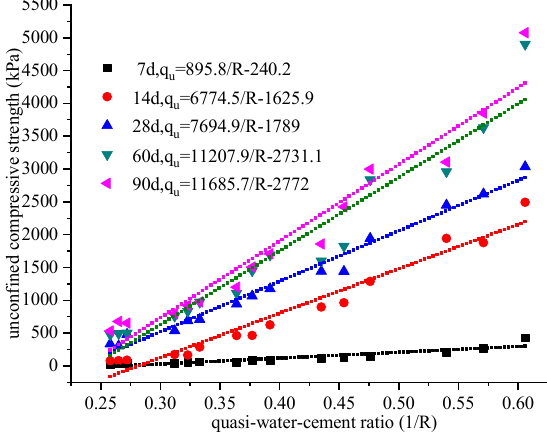
Figure 8. Relationship between the unconfined compressive strengths and the quasi-water-DGSC ratio.